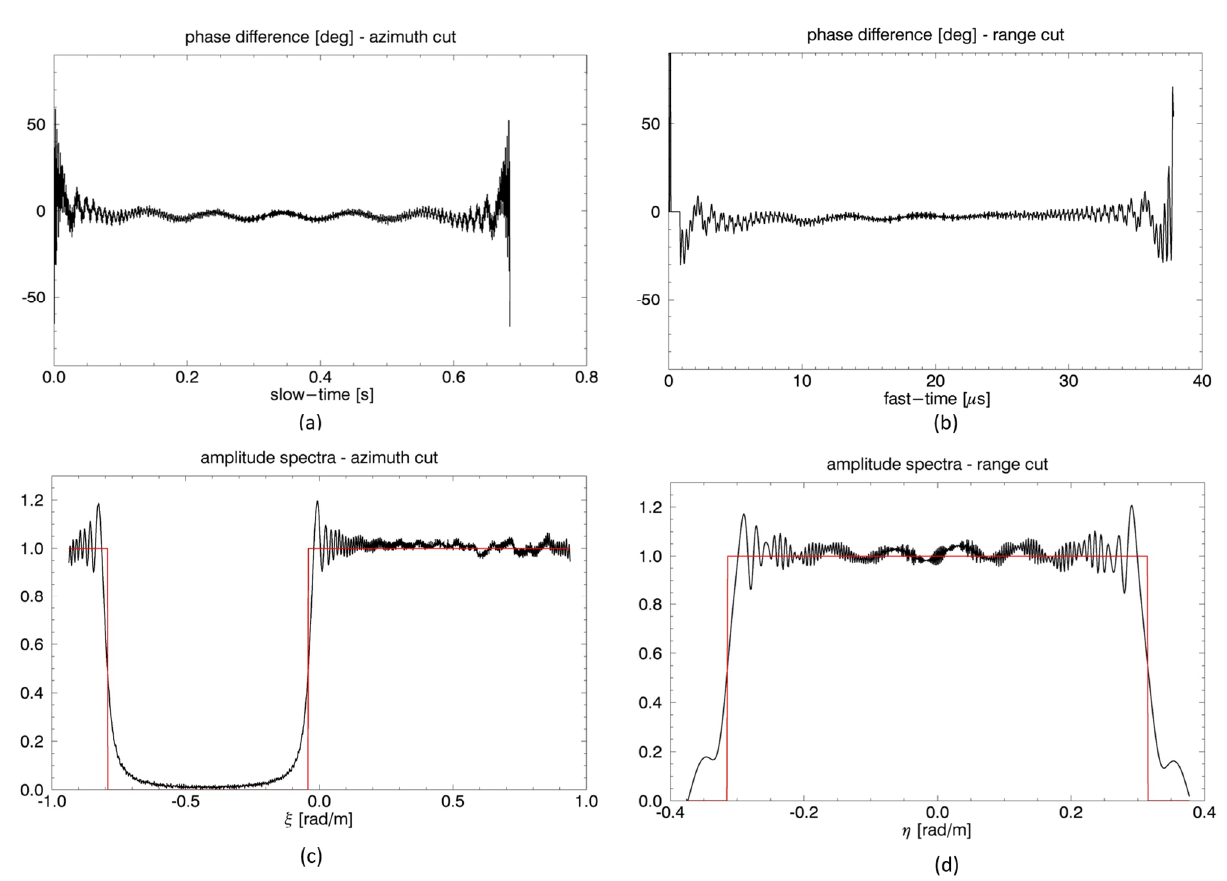
Figure 6. TI configuration, second example. Slow-time ( a ) and fast-time ( b ) cuts of the difference between the phases of the raw signals simulated in time and frequency domains. Slow-time ( c ) and fast-time ( d ) cuts of spectra of raw signals generated via the time (black line) and frequency (red line) domain simulators.